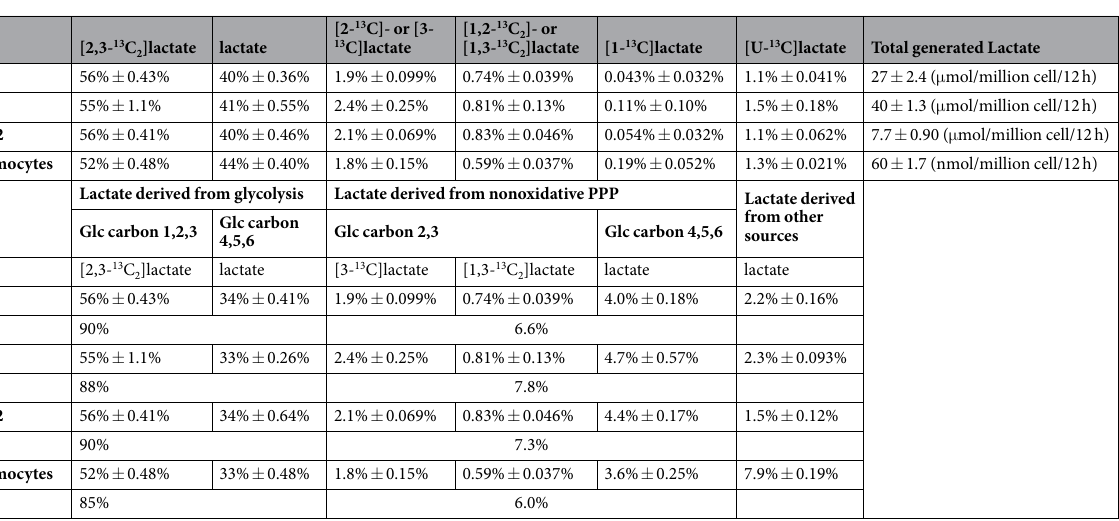
13 C 13 C]pyruvate, which can 2 ]pyruvate and [3-